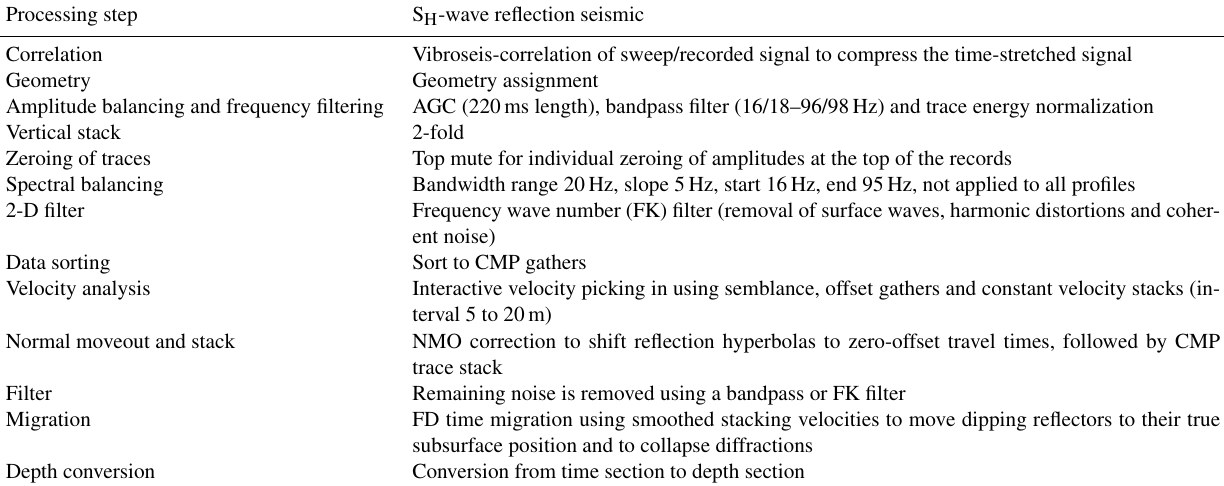
Table A2. General processing sequence applied to S H -wave seismic reflection data. Most of the processing was carried out iteratively and each profile is individualized due to the differing data quality of the